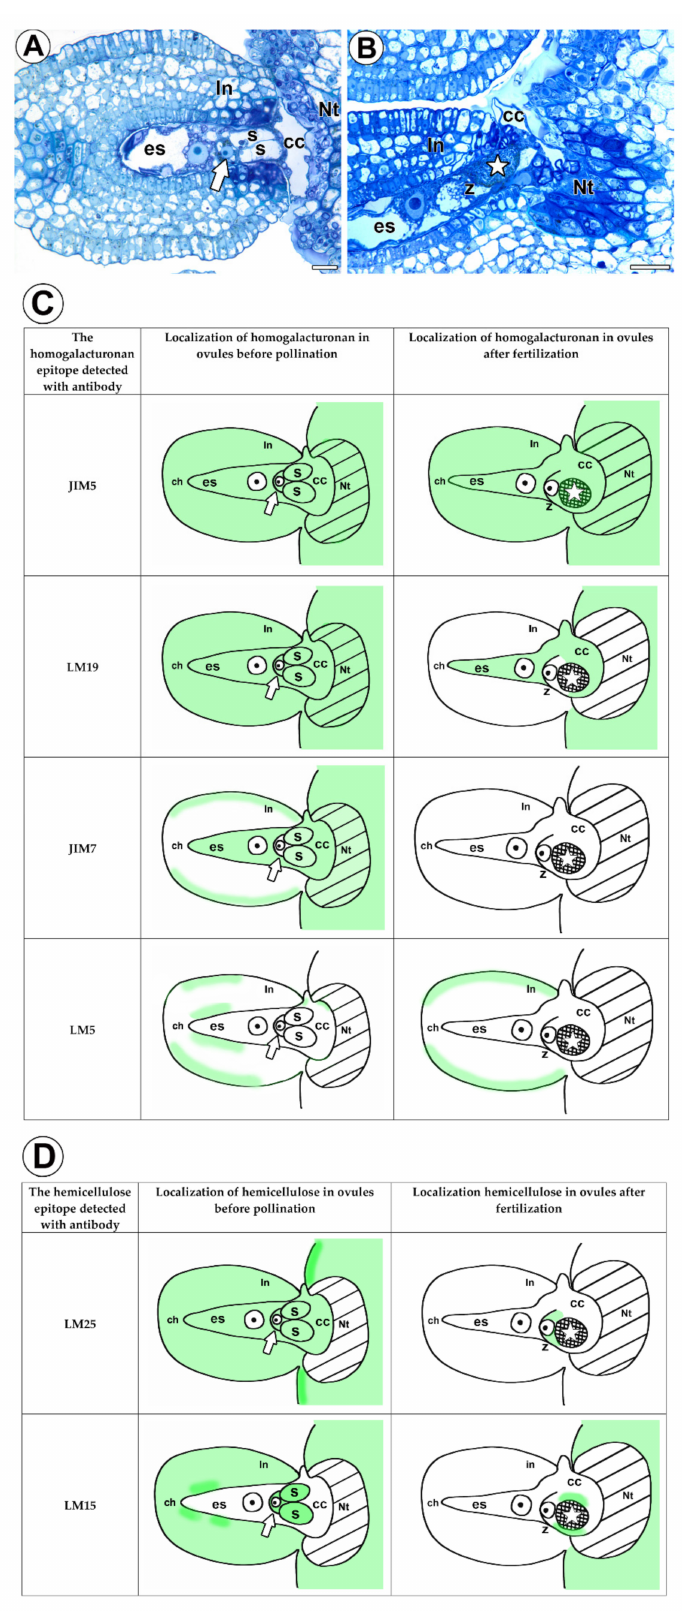
Figure 5. Histology of an ovule of Utricularia nelumbifolia before pollination and after fertilization. Schematic localization of the homogalacturonan and hemicelluloses in the female reproductive structures and tissues of Utricularia nelumbifolia before pollination and after fertilization. Dark